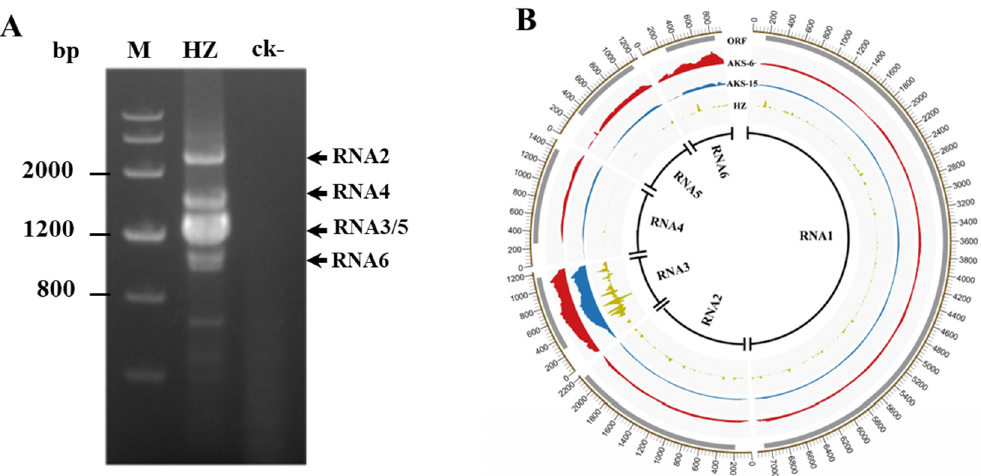
Figure 1. Electrophoresis analysis of RT-PCR products of the genomic RNA segments of jujube yellow mottle-associated virus (JYMaV) in the sample HZ by using the primer set 3C/5H ( A ) and profile distribution of sRNA reads of isolate HZ and RNA reads of two isolates AKS-6 and AKS-15 along genomic RNAs 1–6 of JYMaV-HZ ( B ). ck-, a leaf sample of a healthy jujube plant from Hubei Province. M, DNA marker Ⅲ . ORF in each RNA segment of JYMaV was shown by using a grey line above the read depth graphic in panel B.